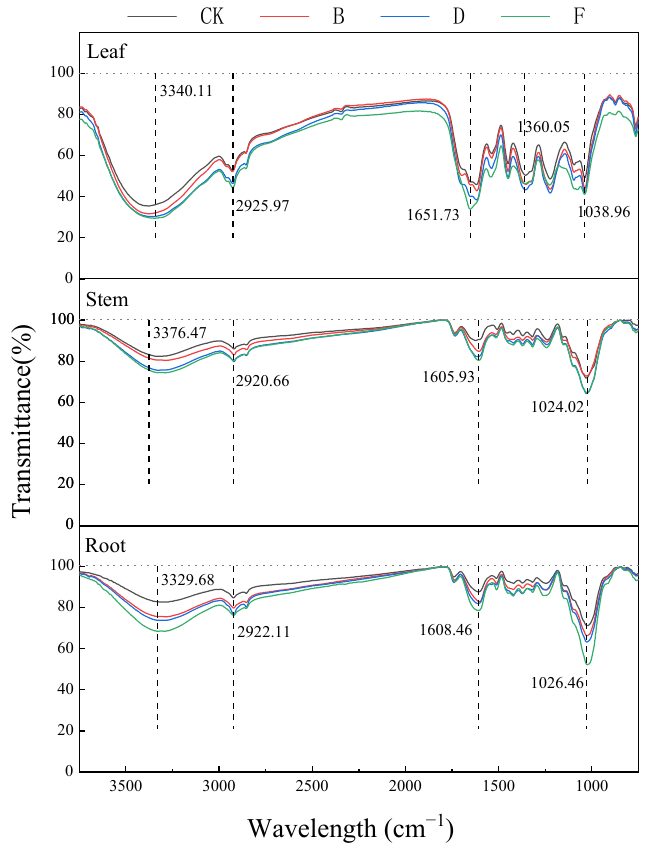
Figure 5. The functional groups of K. paniculata tissues on Pb stress at different concentrations. Note: CK treatment group, B treatment group (400 mg·L − 1 ), D treatment group (800 mg·L − 1 ), and F treatment group (1200 mg·L − 1 ).